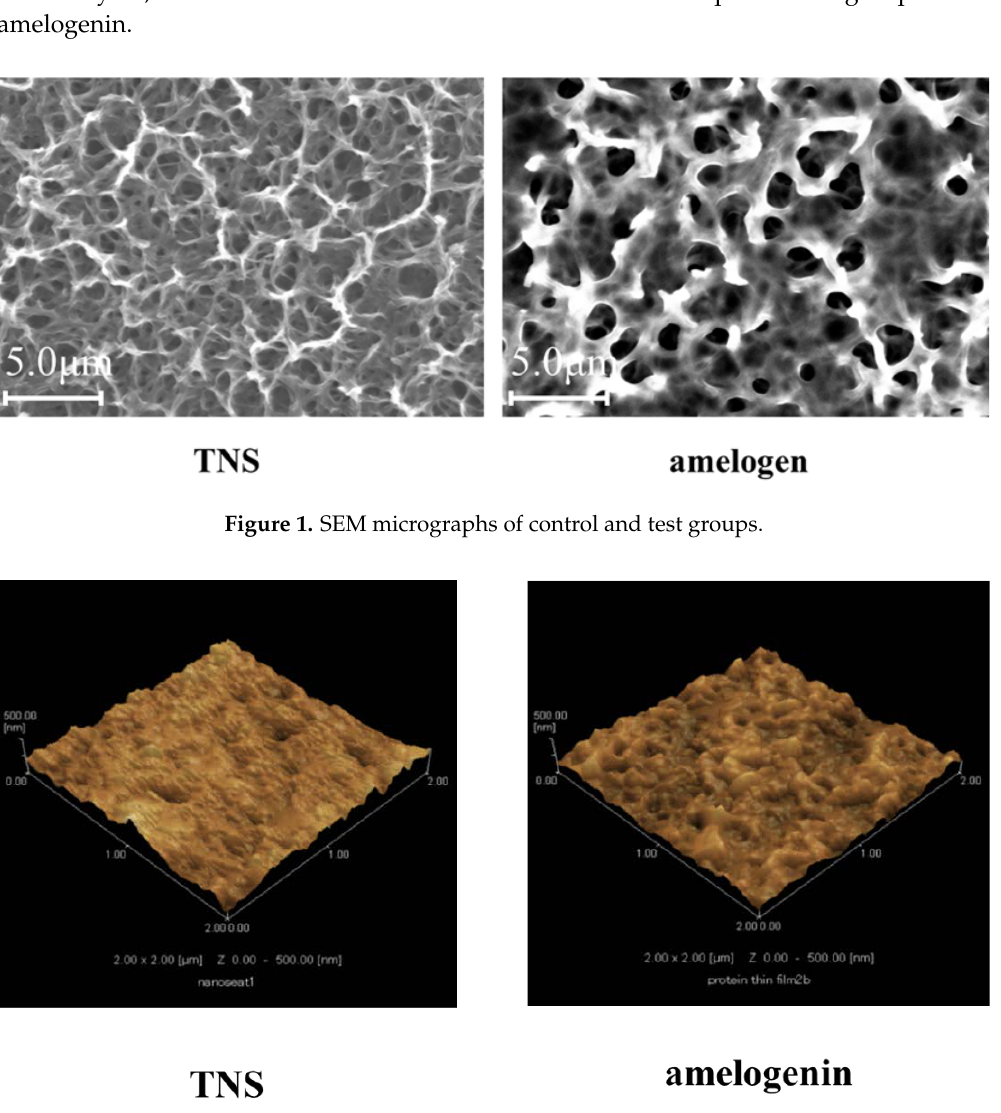
Figure 2. Scanning probe (SP) micrographs of control and test groups.